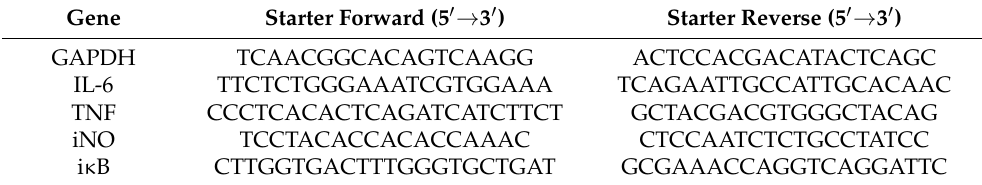
Table 1. qPCR primer sequences. IL-6, interleukin 6; TNF, tumor necrosis factor-alpha; iNOS, inducible nitric oxide synthase; i κ B, inhibitor of nuclear factor κ